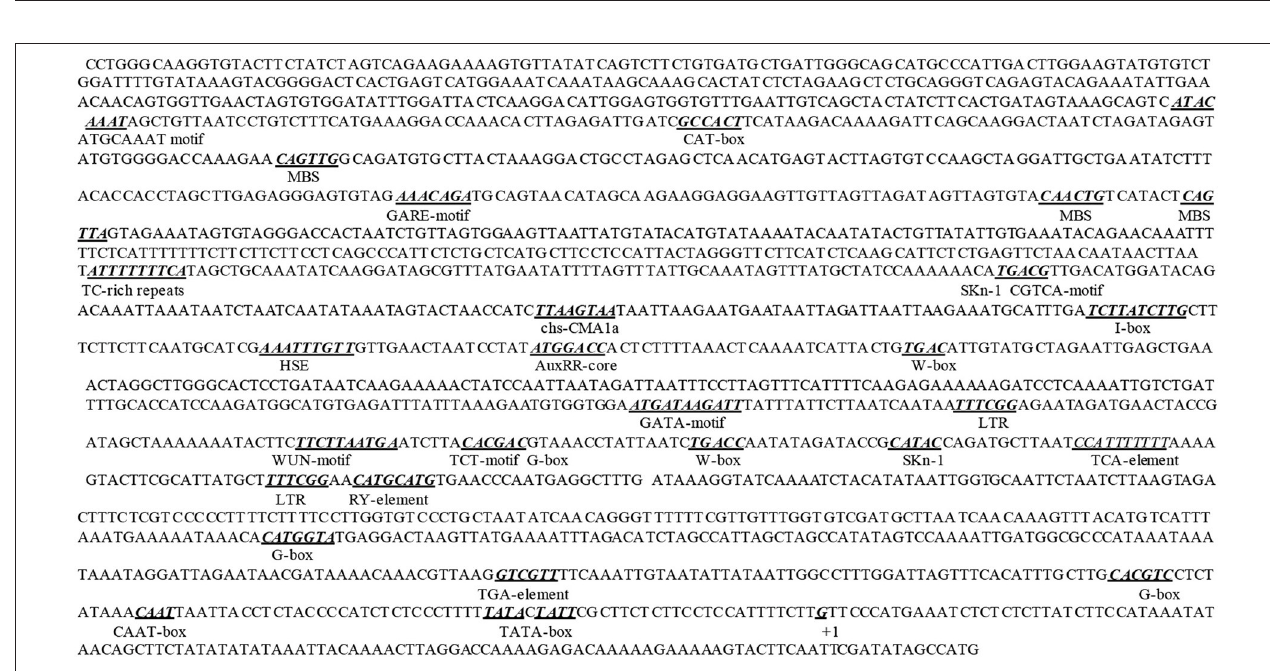
Frontiers in Plant Science |